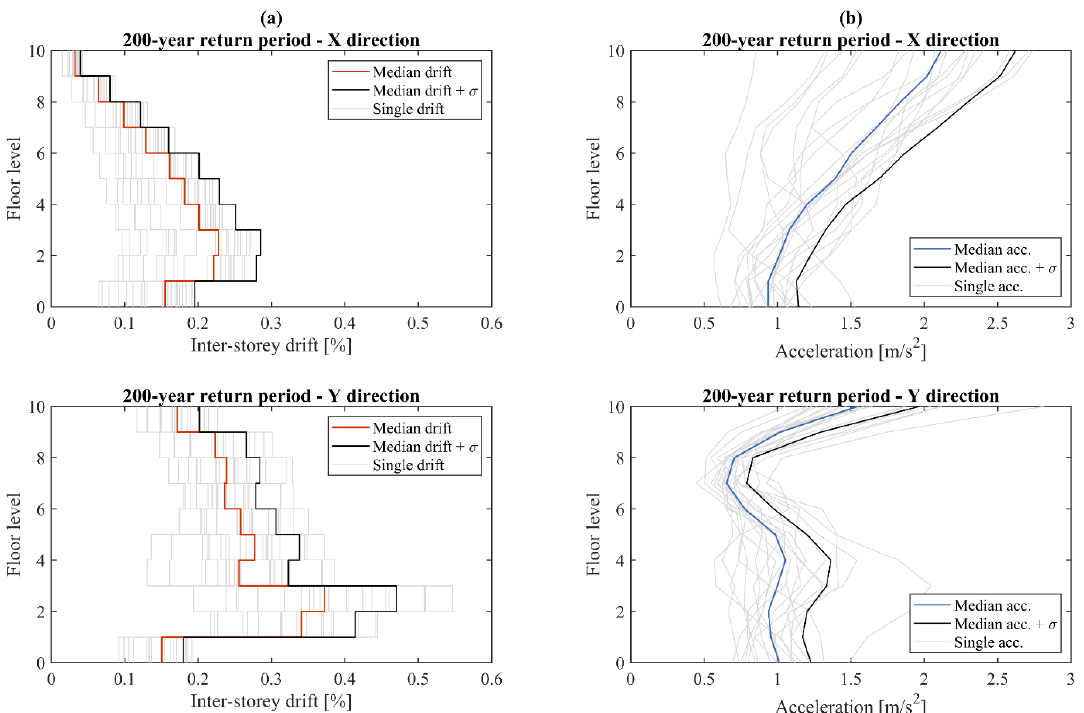
Figure 5. Drift and acceleration peak profiles in longitudinal and transverse directions for RP = 200 years: ( a ) peak storey drifts in X and Y directions; ( b ) peak floor accelerations in X and Y directions. As far as the return period associated with the OLS limit state is concerned, median maximum peak drifts of about 0.17% and 0.3% were observed in X and Y directions, in-between the second and third floors, indicating that the building is more flexible in its transverse direction. In both cases, however, the 0.33% drift upper limit prescribed in the Italian code [27] is fulfilled. Moreover, it is